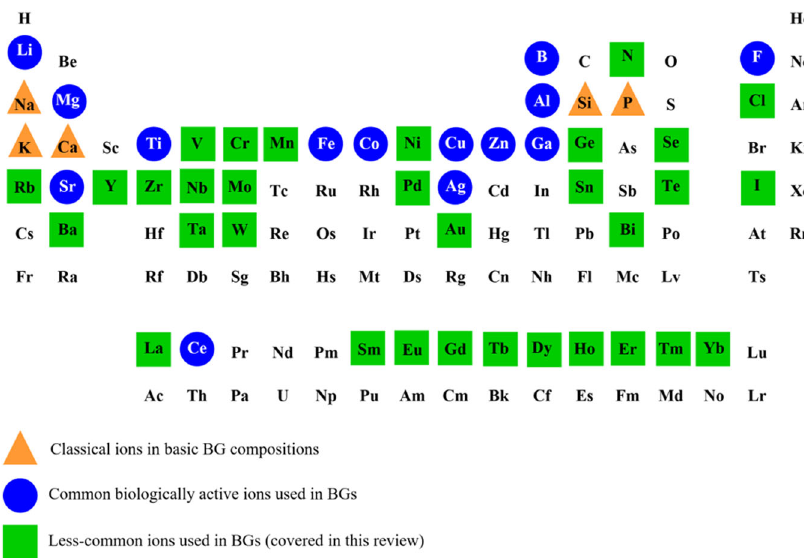
Fig. 1 Periodic table of the elements highlighting the classical ions used to produce BGs, ions highly investigated to provide biological and therapeutic properties to BGs, and less-common ions in BGs, which are the ones covered in this